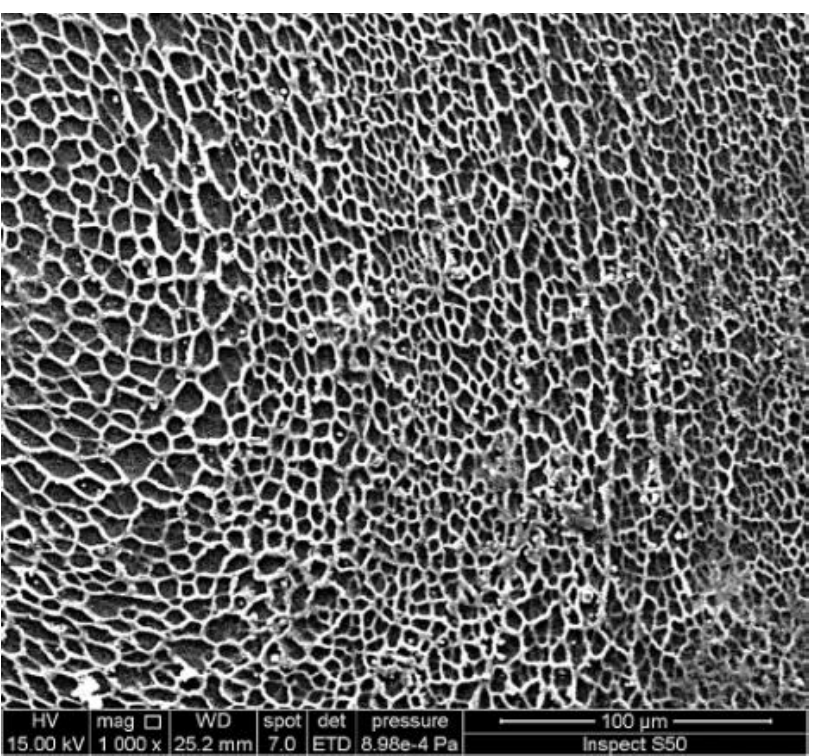
Figure 6. SEM image of the surface of an irradiated PVC film blended with a polyphosphate containing a benzidine moiety.